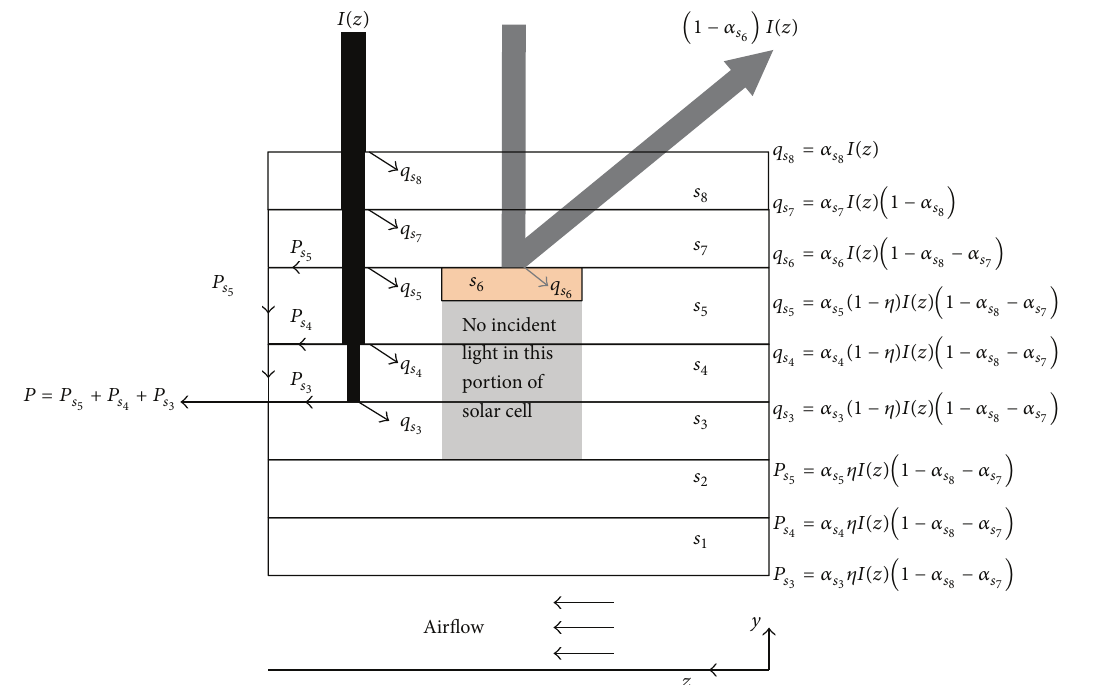
Figure 2: Energy fluxes in solar cell